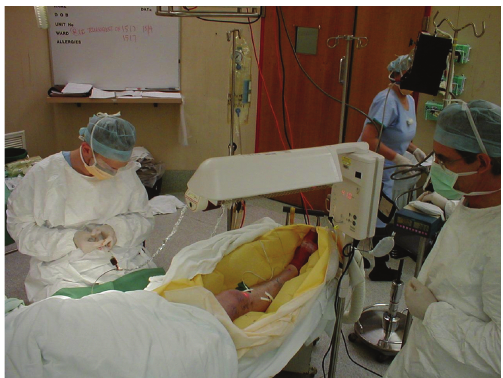
Figure 2: Photograph of an isolated limb infusion procedure in progress in the operating theatre